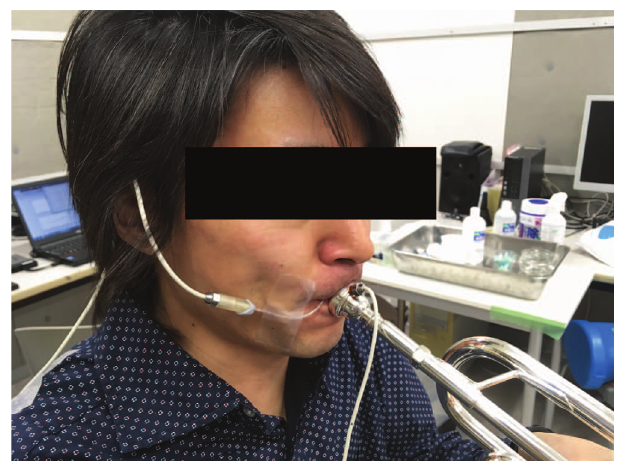
Figure 3. Trumpet player during experiments: two miniature pressure sensors are used to measure the upstream (mouth) and downstream (mouthpiece) pressures during performance.